Question: Which visualization type does this figure use?
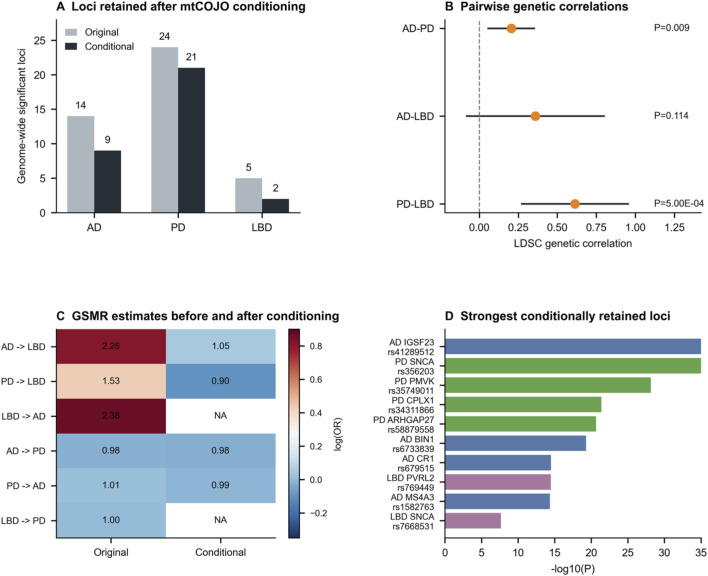
Answer: bar